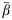
Basic modeling and network features.(a) Scheme of the interaction between RNA species i and miRNA species a. Synthesis, degradation, association and dissociation processes are shown with their respective rates. (b) Sketch of a bipartite miRNA-RNA network. RNA species can crosstalk via chains of miRNA-mediated effective interactions, as can do species 1 and 3 in this example. (c1-c4) Classes of miRNA-RNA interactions considered in this work (following [45]): (c1) perfect k-base-pairing in the seed region (’k-mer’ mode); (c2) seed base-pairing with up to one mismatched or bulged nucleotide (non-canonical mode or ‘seed-nc’); (c3) non-seed base pairing with bulged and/or mismatched nucleotides (’noseed-9nt’ mode); (c4) non-seed binding within weak diffuse regions (’noseed’ mode). (d) Frequency of each binding mode in the CLASH dataset (from [45]). (e) Distributions of RNA transcription rates used in this work: each rate is assumed to be drawn independently from a lognormal distribution with given mean (same for each RNA species). Increased transcriptional heterogeneity (TH) corresponds to increased values of the relative fluctuations (CVtr). (f) Scenarios of miRNA-RNA binding heterogeneity (BH) analyzed in this work. From left to right: low BH, where each miRNA-RNA pair interacts with the same strength; medium BH, with k-mer interactions (stronger) distinguished from the rest (weaker); high BH, where the full structure described in panel (d) is employed. (g) Relative abundance of miRNAs and RNAs as a function of the global average miRNA transcription rate in the CLASH interactome for representative values of kinetic parameters. The ‘susceptible’ regime in which global RNA levels are more sensitive to variations in miRNA availability occurs at intermediate values of β¯.